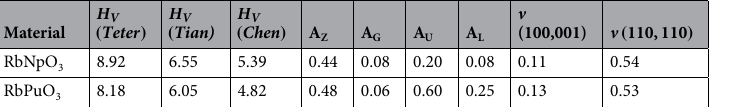
Table 5. Intended values of Vickers Hardness ( H V ) , Anisotropic parameters and extrema of Poisson’s ratio for RbMO 3